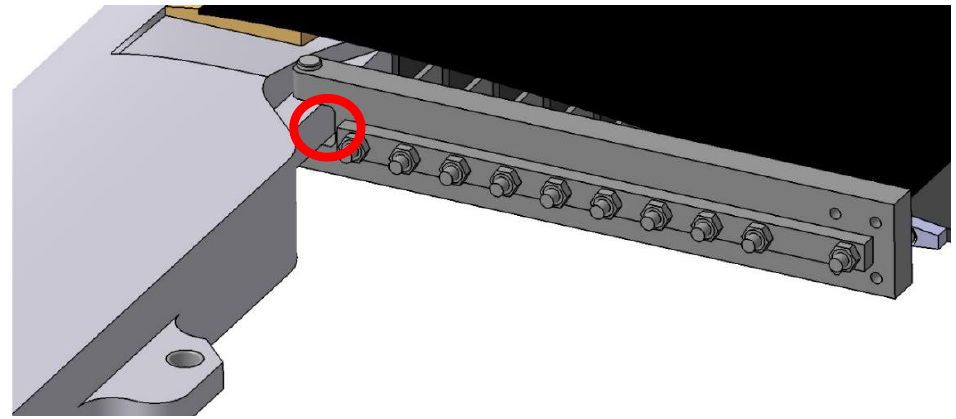
Figure 9. Strain gage location at the root.